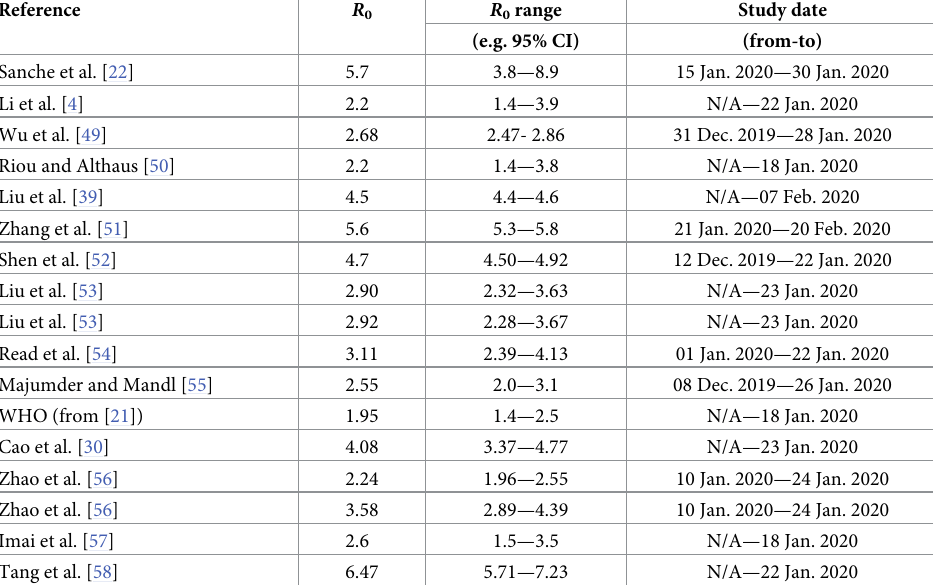
Table 1. Compilation of published R o estimates.